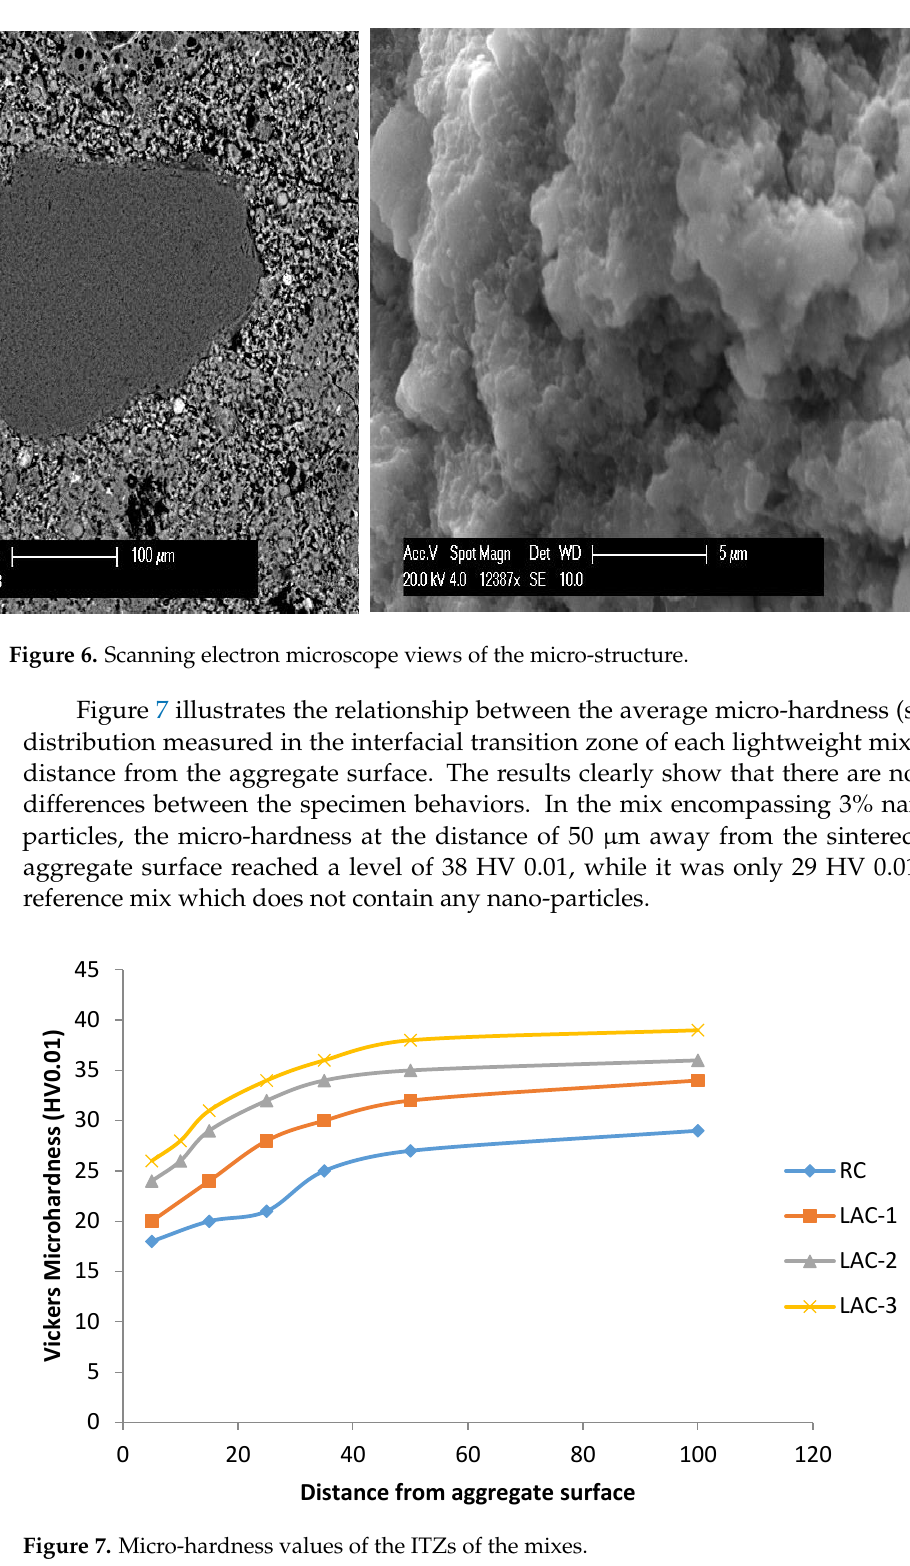
Figure 5. The compressive strength test results of the mixes.